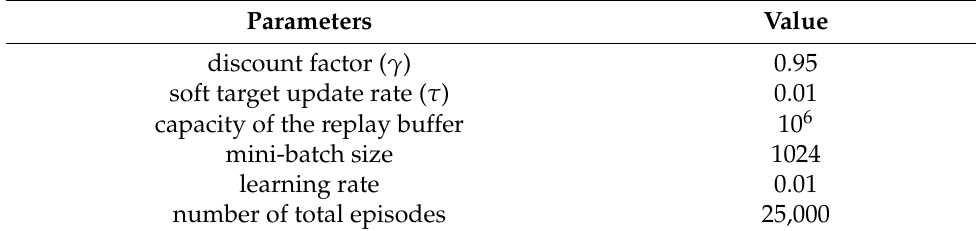
Table 2. Hyperparameters for